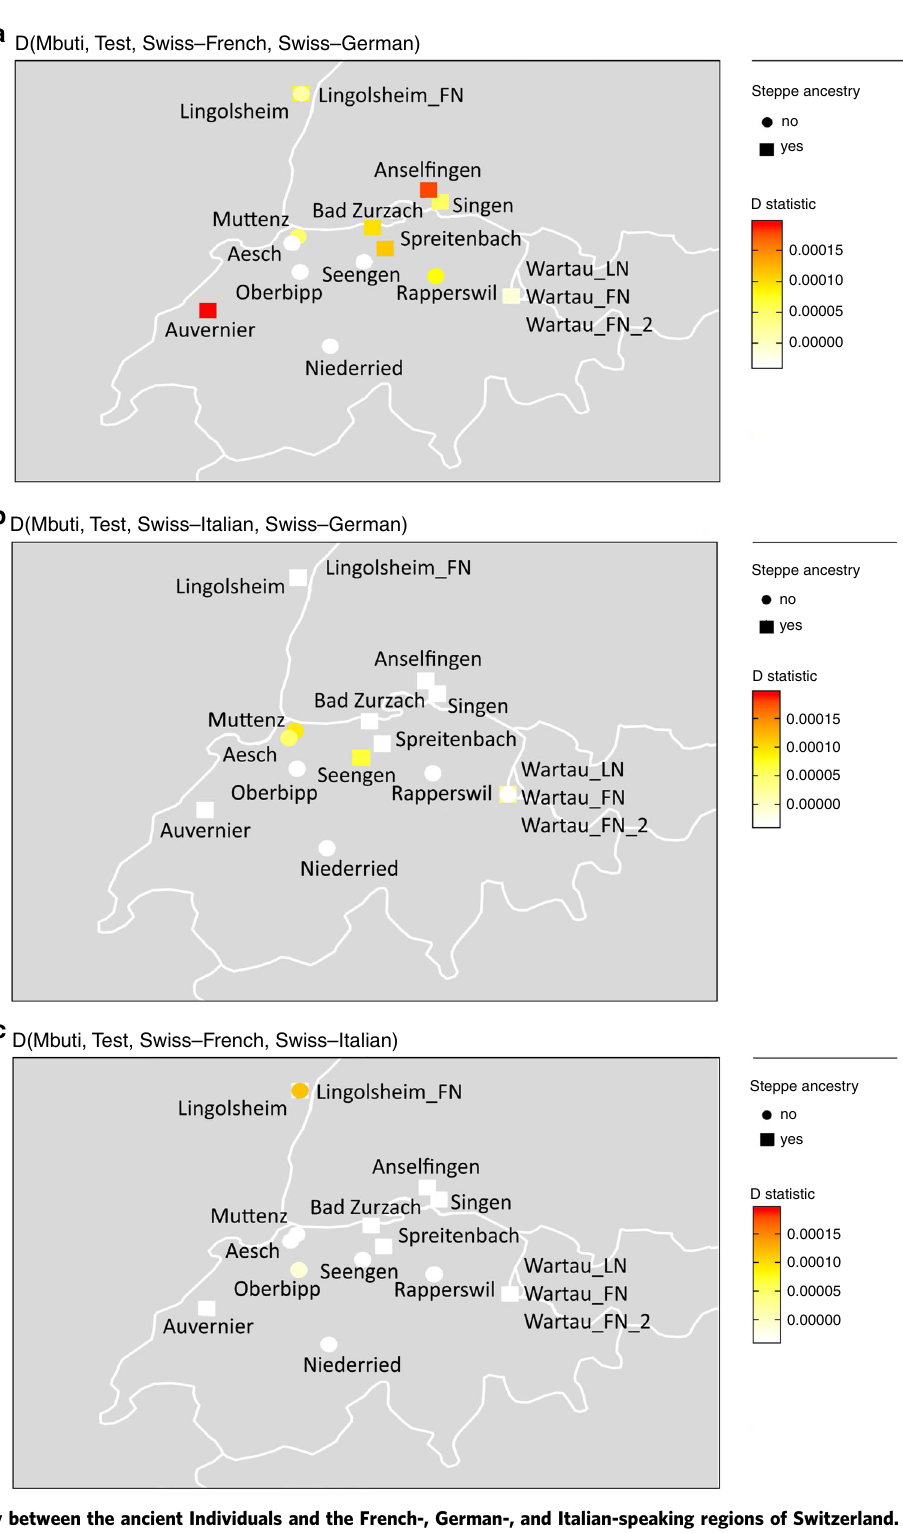
Fig. 5 Genetic af fi nity between the ancient Individuals and the French-, German-, and Italian-speaking regions of Switzerland. Differences in genetic af fi nity of the ancient individuals from Switzerland to a Swiss – French and Swiss – German, b Swiss – Italian and Swiss – German, and c Swiss – French and Swiss – Italian. Maps generated with R version 3.4.3 (R Core Team 2017) using the CIA World Data Bank II are currently (mid 2003) available from